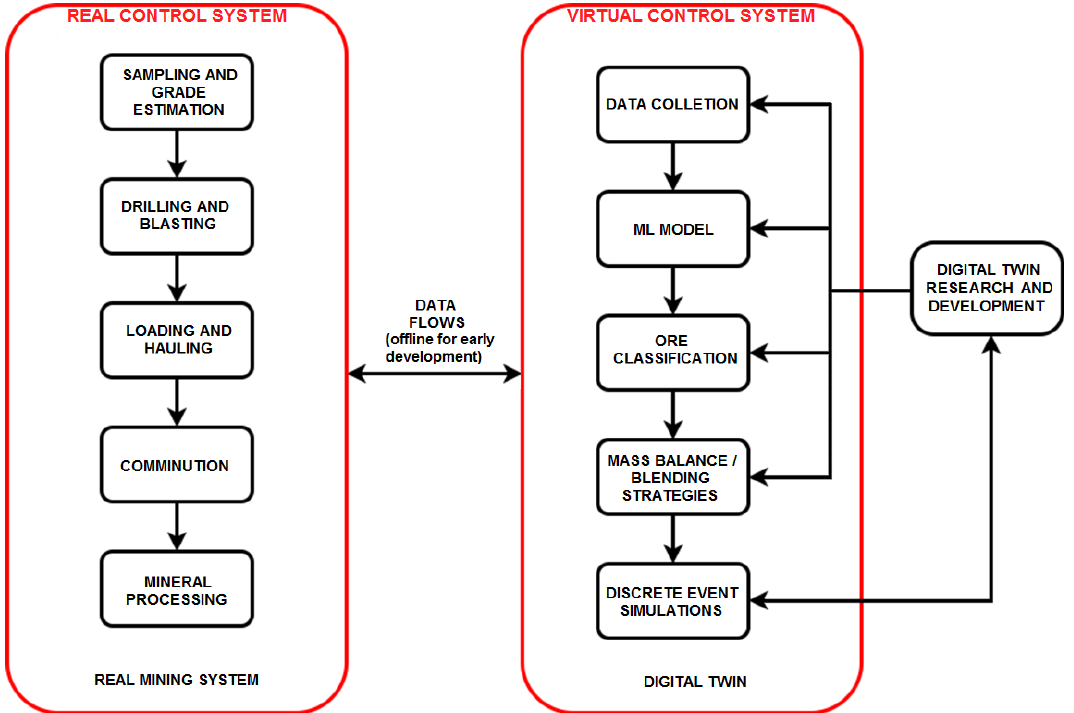
Figure 5. Proposed methodology for digital twin development, in which data flows that interconnect the real and virtual control systems are initially offline (i.e., through data file transfer). Upon further development, a portion of the data flows are brought online (i.e., through a data interface).